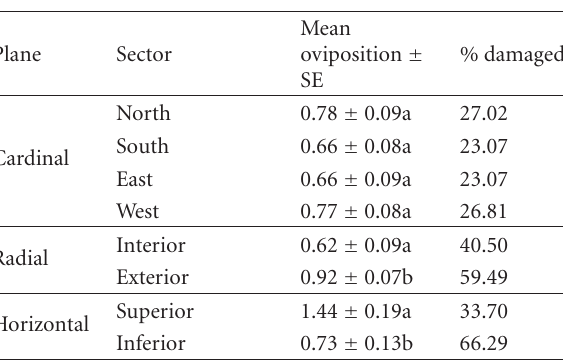
Table 1: Average of damage from Conotrachelus dimidiatus in guava trees in Calvillo, Aguascalientes.